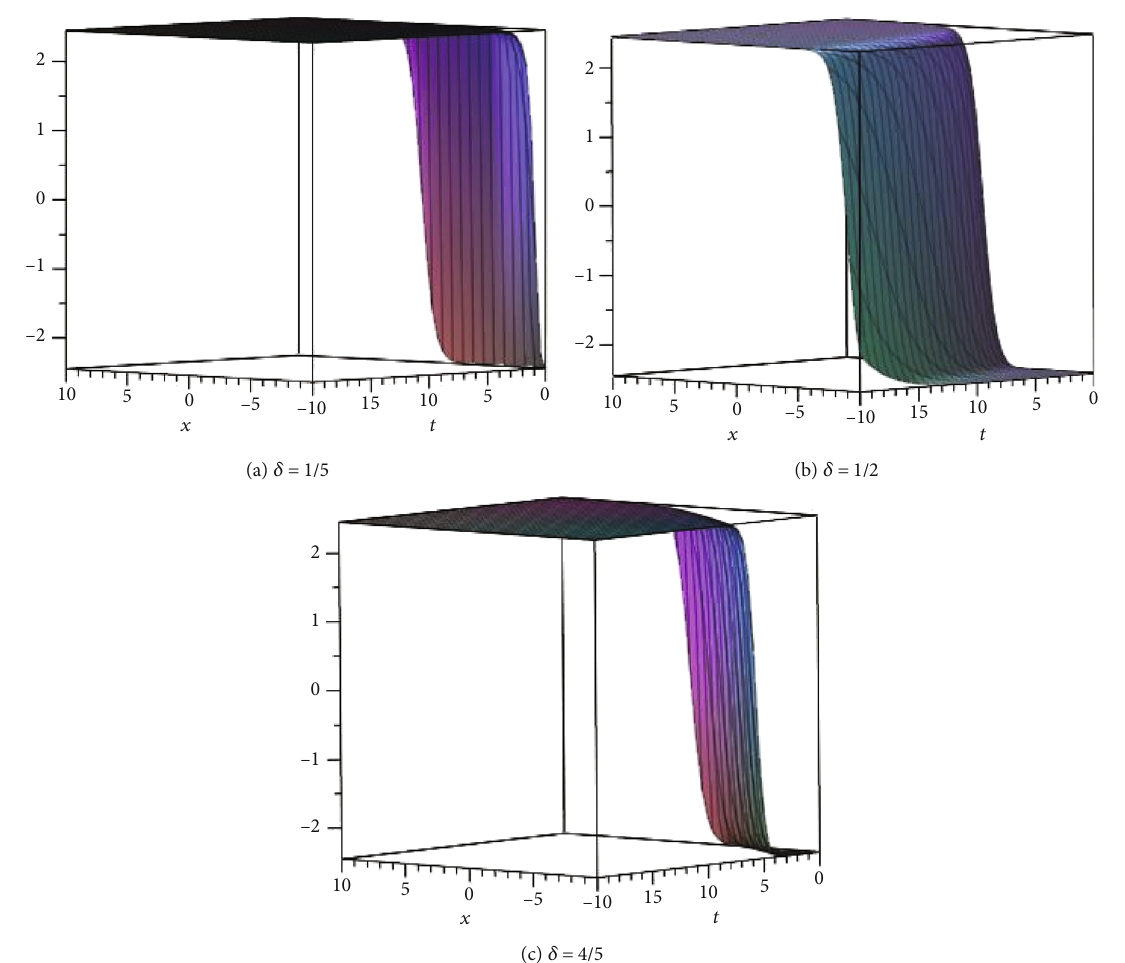
, x Þ in Equation (23) for di ff erential values of the fractional parameter δ Figure 1: The positive real part of u 1 1 ð t